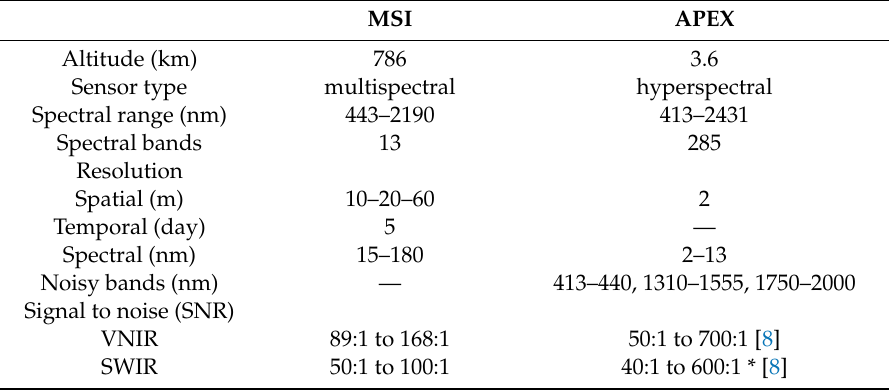
Table 1. Comparison of the Multispectral Instrument (MSI) on board the Sentinel-2 constellation and the Airborne Prism Experiment (APEX) sensor’s characteristics [29,33]. VNIR = visible and near-infrared, SWIR = shortwave infrared. MSI APEX Altitude (km)